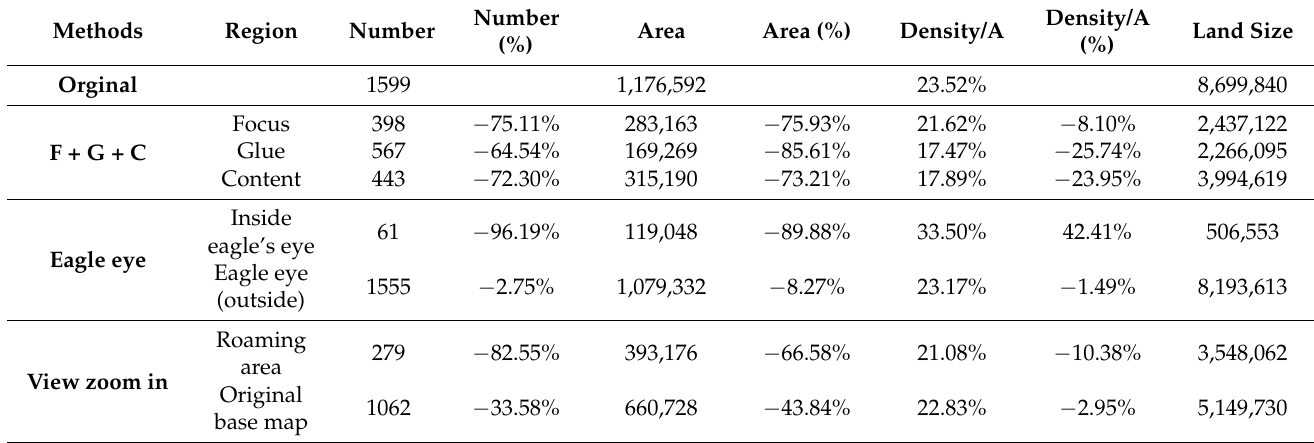
Table 2. Evaluation results of building quantity, area, and density by different methods.